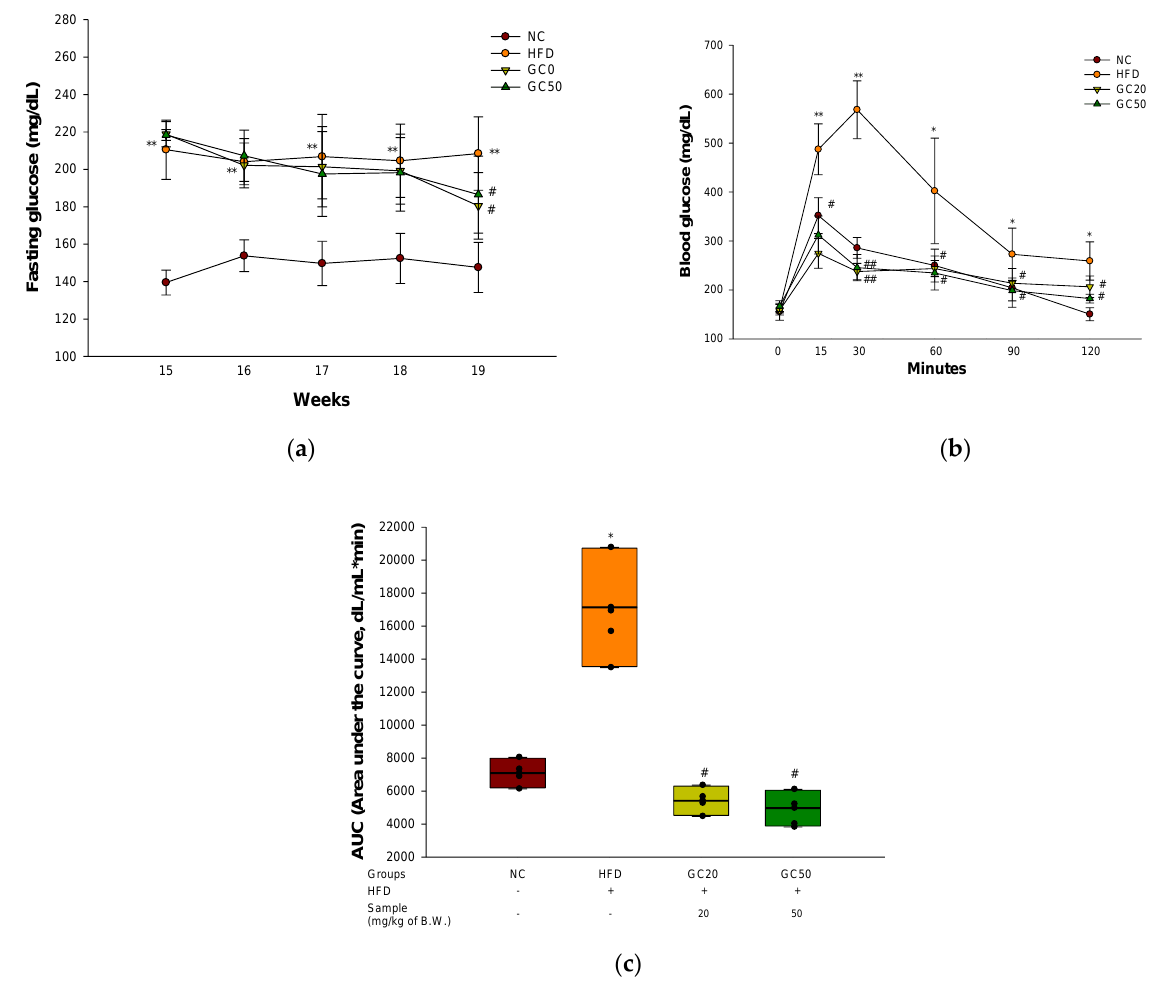
Figure 4. Protective effect of 80% ethanolic extract from Gimcheon 1ho (GC) cultivar walnut ( Juglans regia ) in HFD-induced mice: ( a ) fasting glucose; ( b ) oral glucose tolerance test (OGTT) at 19 weeks old; ( c ) area under the curve (AUC) of OGTT. Results shown are mean ± SD ( n = 5). Data are statistically represented with * = significantly different from the NC group, and # = significantly different from PM group; * and # p < 0.05, ** and ## p < 0.01. Bold line indicates mean.